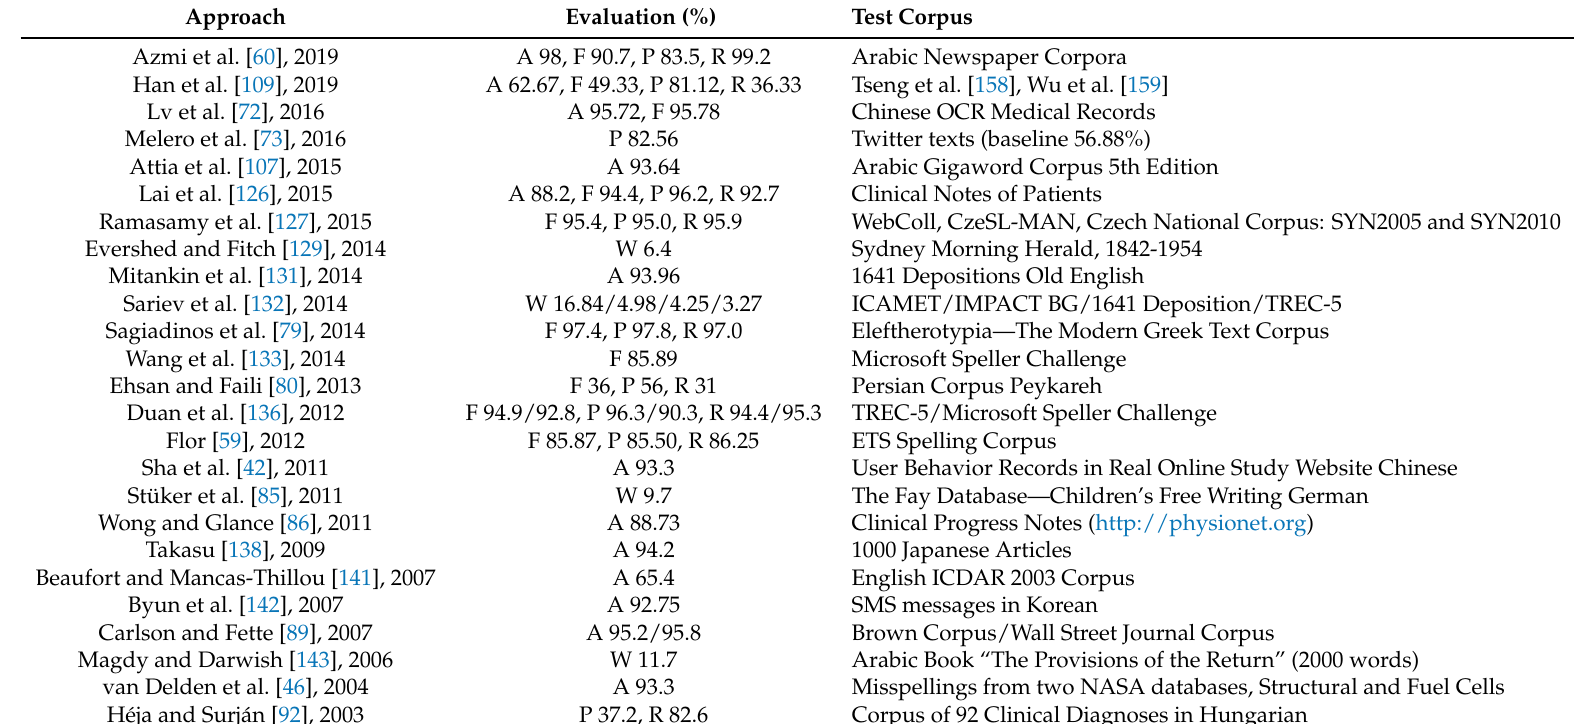
Table 7. Reported evaluation